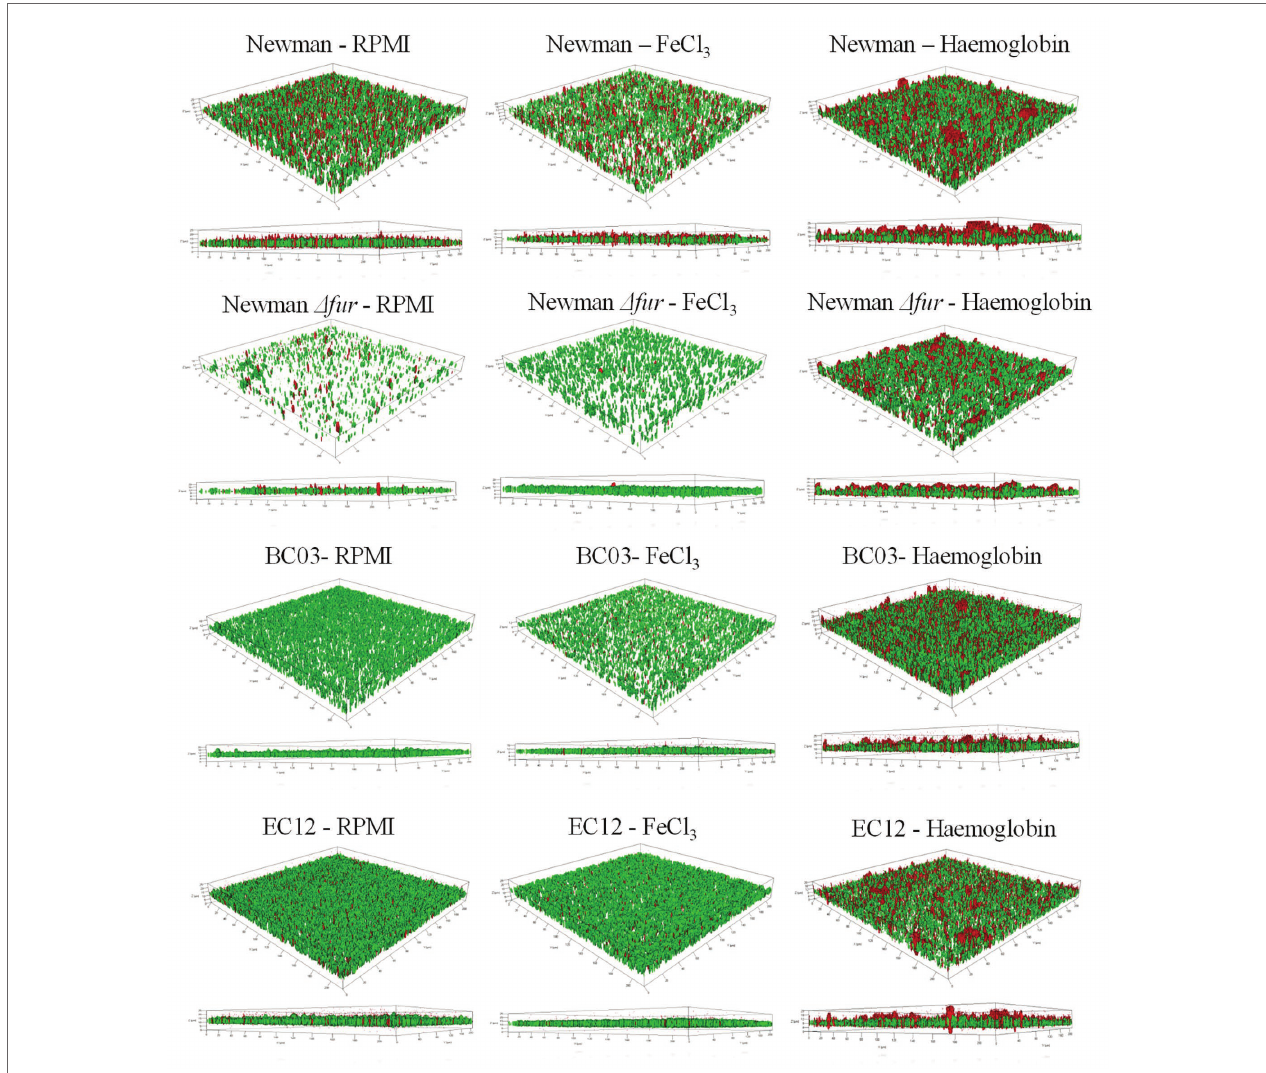
FIGURE 2 | Representative CLSM Z-stacks of S. aureus biofilms grown under three iron treatments. An iron restricted overnight culture was resuspended in fresh medium and diluted to a final concentration of 1 × 10 7 CFU ml −1 in 1 ml of medium (RPMI, 40 μ M of FeCl 3 or 10 μ M Hb) in a 24-well plate (BD Biosciences). The multi-well plate was incubated for 24 h at 37 ° C in a static incubator. Spent medium was removed from each well, and biofilms were carefully washed twice with 1 ml of PBS before samples preparation for microscopy. Syto 9 (green) represents live cells and Propidium iodide (red) represents dead cells. 3D images were made with ZEN